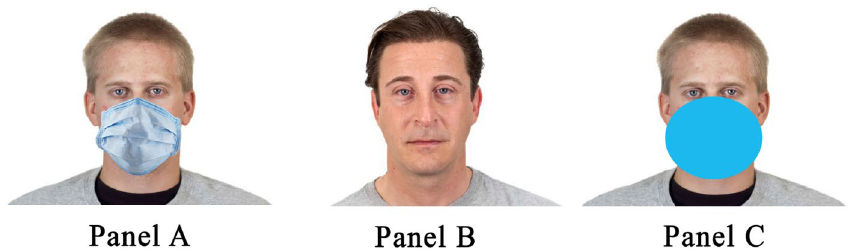
Figure 1. Examples of the face stimuli used in Study 1 (panel A and B ) and in Study 2 (panel A , B , and C ). Stimuli without the mask/spot were extracted from the Chicago Face Database 46 —complying with the terms of use—and then edited to superimpose the face mask or the